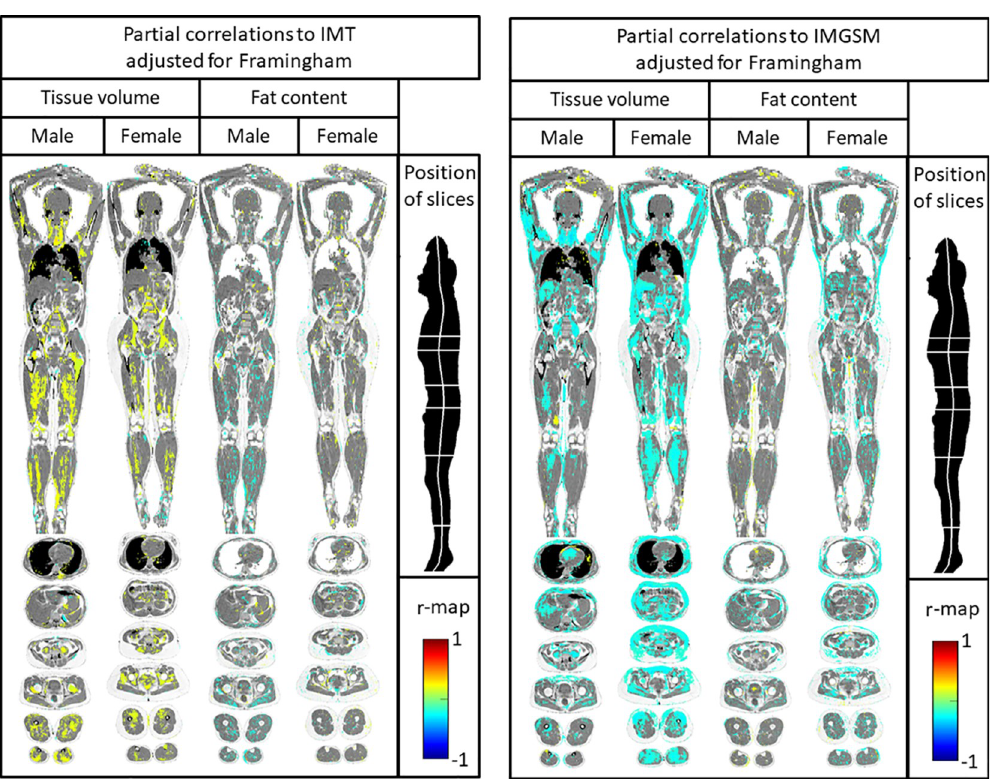
Fig 4. Imiomics correlation maps showing relations between tissue volume/fat content and carotid artery intima-media thickness (IMT) (left panel) and the echogenicity of the intima-media (IM-GSM) (right panel), when corrected for Framingham risk score. Significant (P < 0.05) voxelwise partial parametric correlation values, with Framingham risk score as the confounding variable, are shown in the colorscale in the lower right. Pixels with non-significant correlations show the underlying water signal values. One Coronal slice and six axial slices are shown, as given by the illustration in the upper right part of the figure.